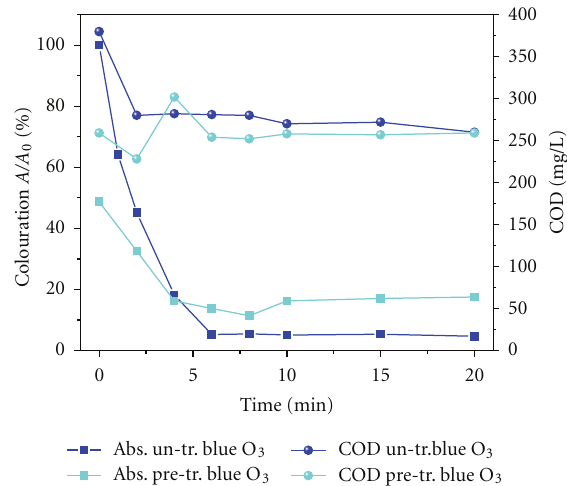
Figure 9: Colouration expressed as A/A 0 and COD values of Reactive Blue 19 wastewater samples at di ff erent times of PCOz irra- diation. Square symbols in all graphs represent absorbance values of untreated and pretreated samples; sphere symbols represent COD values of the same samples.